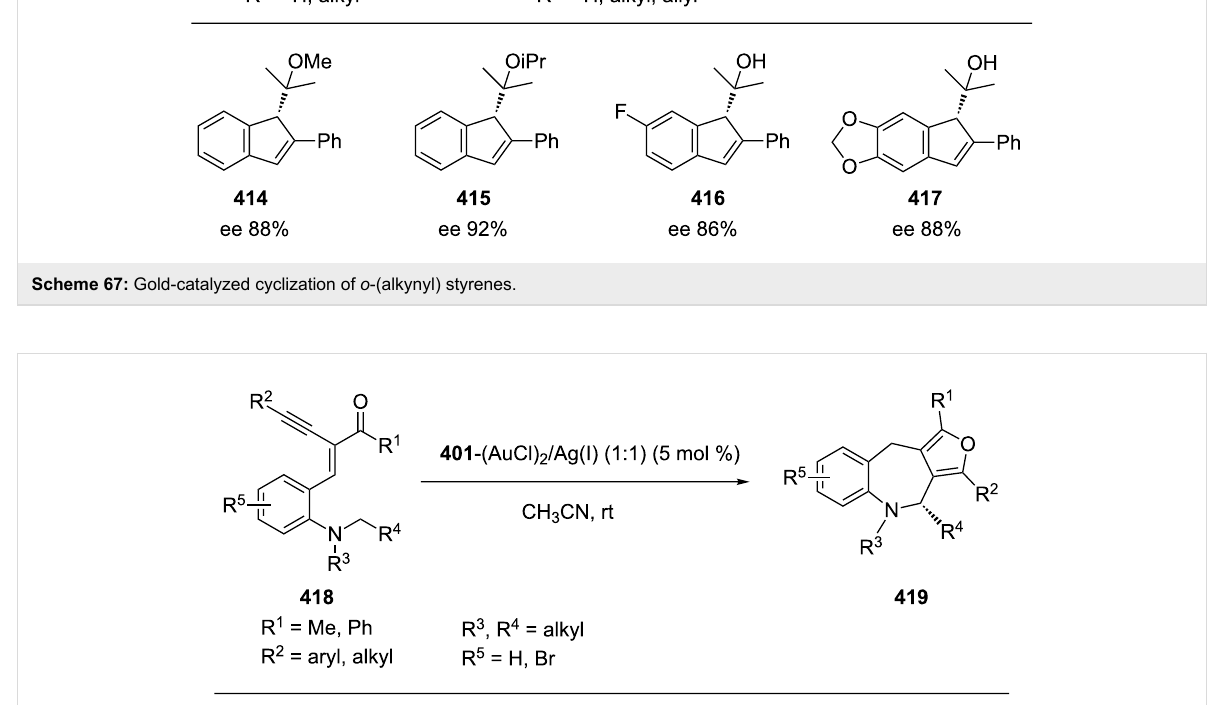
The use of 3,5-( t -Bu) 2 -4-MeO-MeOBIPHEP 401 resulted in the formation of fused bicyclic compounds ( 424 , 426 , 428 , 430